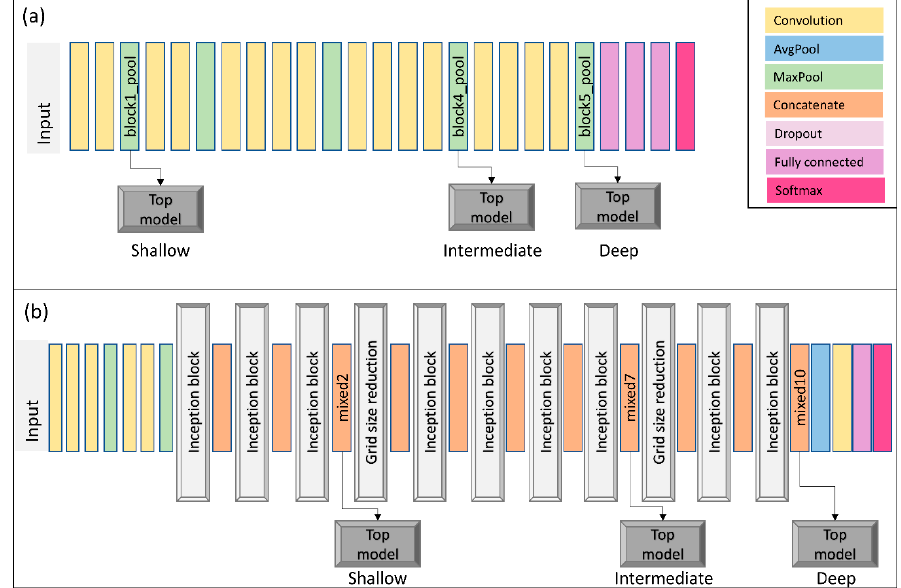
Figure 2. Visual representation of the models used. In both panels, data flows from left to right. Both panes use the same color code for layer representation. ( a ) shows the VGG19 shallow, intermediate,